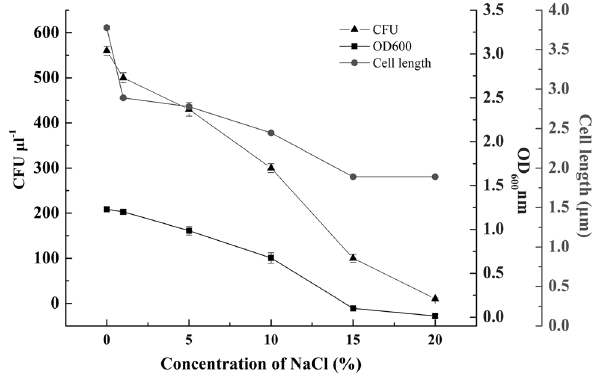
Figure 1: Growth condition of the bacterial strain SX4 under NaCl